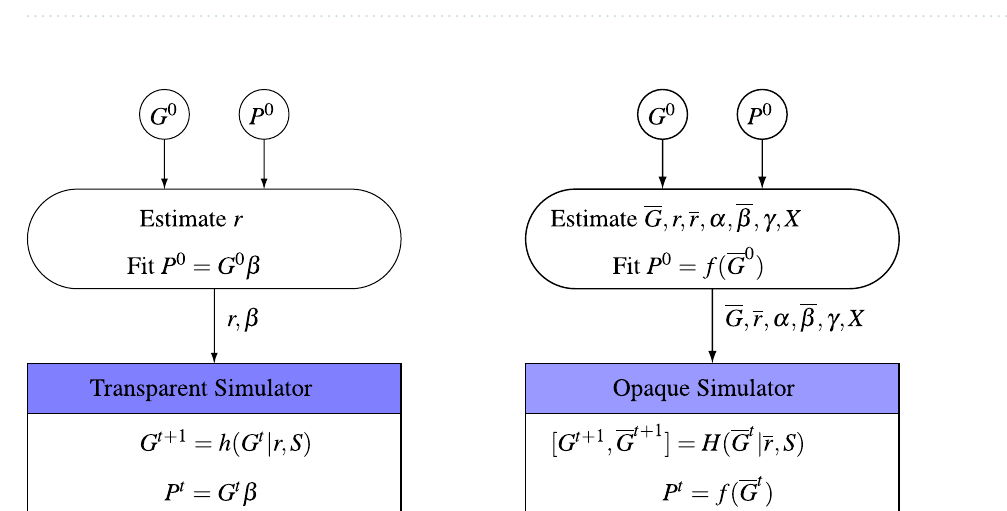
Figure 1. Roles of simulator and optimizer in genomic selection.